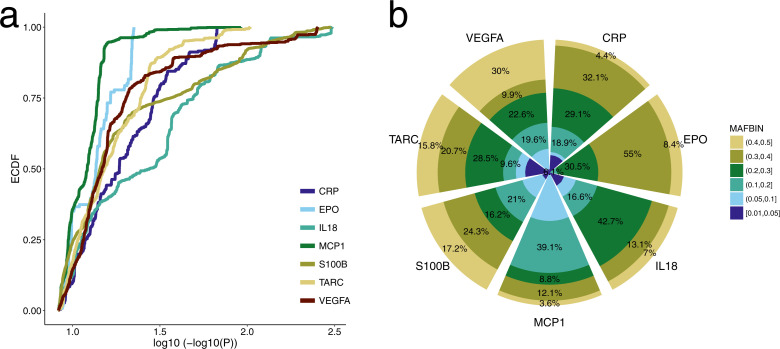
Distribution of association statistics for inflammation marker level a.The empirical cumulative distribution function of the log10(-log10(P)) for the association of SNPs (P<5x10-9) with each inflammation marker. Colors indicate different markers. b. Distribution of SNPs (P<1x10-9) in different minor allele frequency (MAF) bins is shown for each marker. Colors indicate different MAF intervals. Numbers in the figure shows the proportion of SNPs in the region.